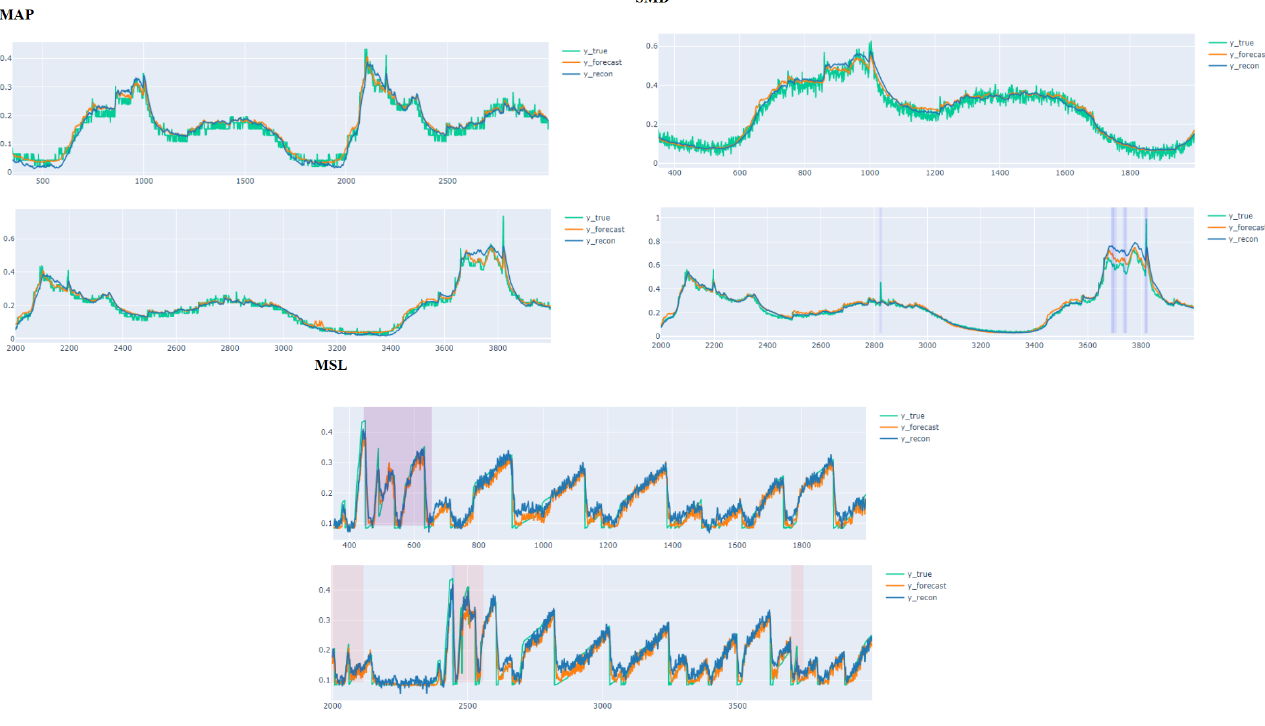
Figure 5. Detection effect of the Anomaly-PTG model.